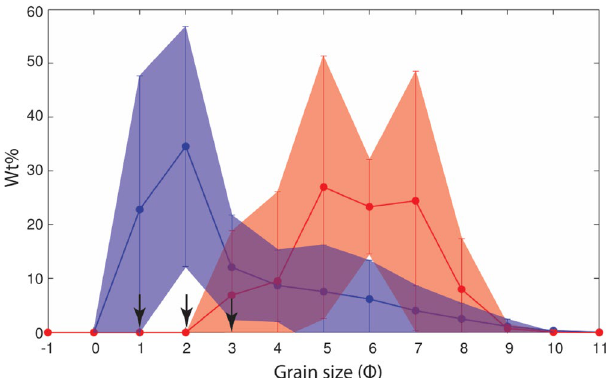
Figure 7. Comparison between the GSD of tephra samples from six eruptions (eruptions A, B, E, G, I and J; Fig. 4a) shown in blue, and the GSD of two types of aggregate (PC2 and PC3) determined from the SEM images for 3 eruptions (eruptions C, H and K; Fig. 4b), shown in red. The position of the arrows indicates the size of the coated particles that were 325 μm and 158 μm (2 and 3 Φ) and of the core of PC3 that was 523 μm